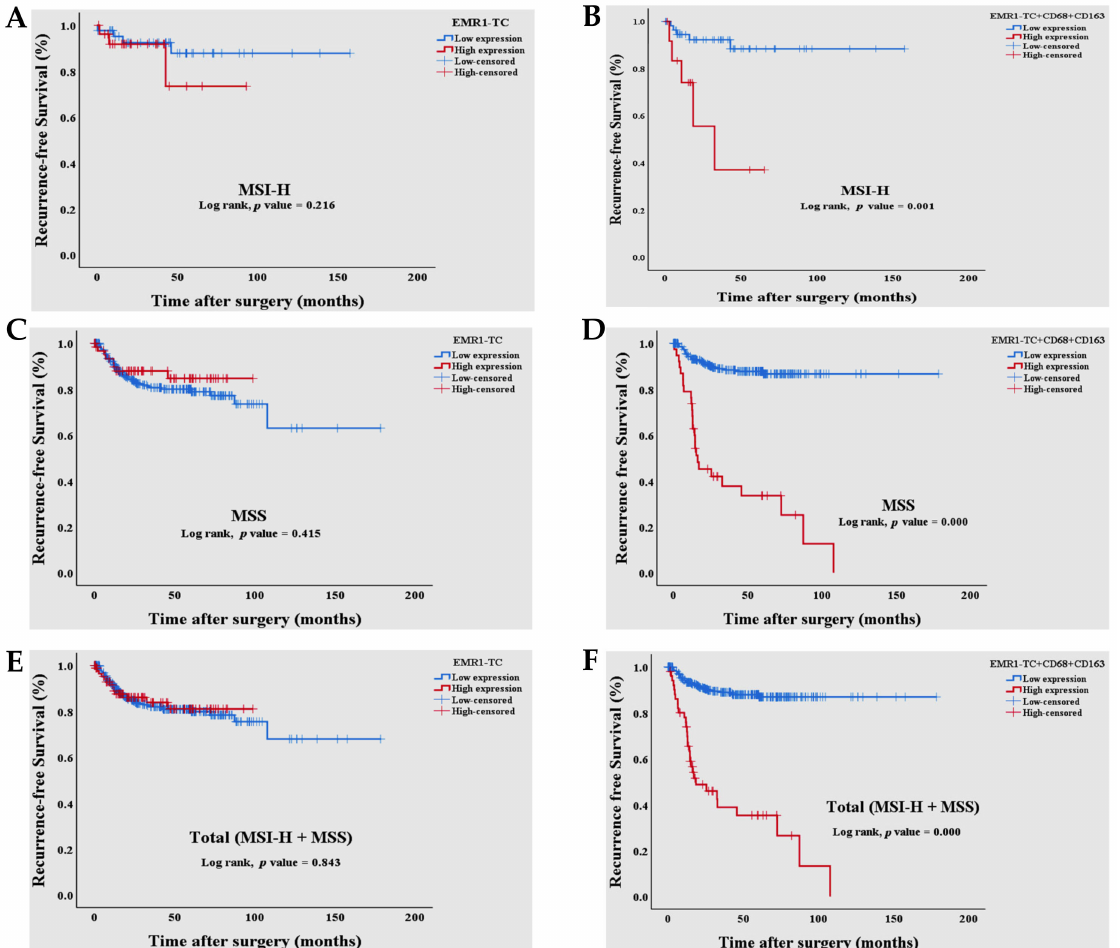
Figure 3. A high combined EMR1-TC + CD68 + CD163 + expression illustrated the poor RFS in CRC. ( A , C , E ) Kaplan–Meier curves showed that there was no significant difference between high EMR1-TC expression compared to low expression; ( B , D , F ) However, high combined EMR1-TC + CD68 + CD163 + expression was significantly associated with worse RFS in MSI-H and MSS CRC compared to low combined expression. The p -value was obtained using the log-rank test of the differences. Statistical significance was set at p < 0.05. Abbreviations: CD, cluster of differentiation; CRC, colorectal cancer; EMR1-TC, EMR1 expression in tumor cells; MSI-H, microsatellite unstable; MSS, microsatellite stable; RFS, recurrence-free